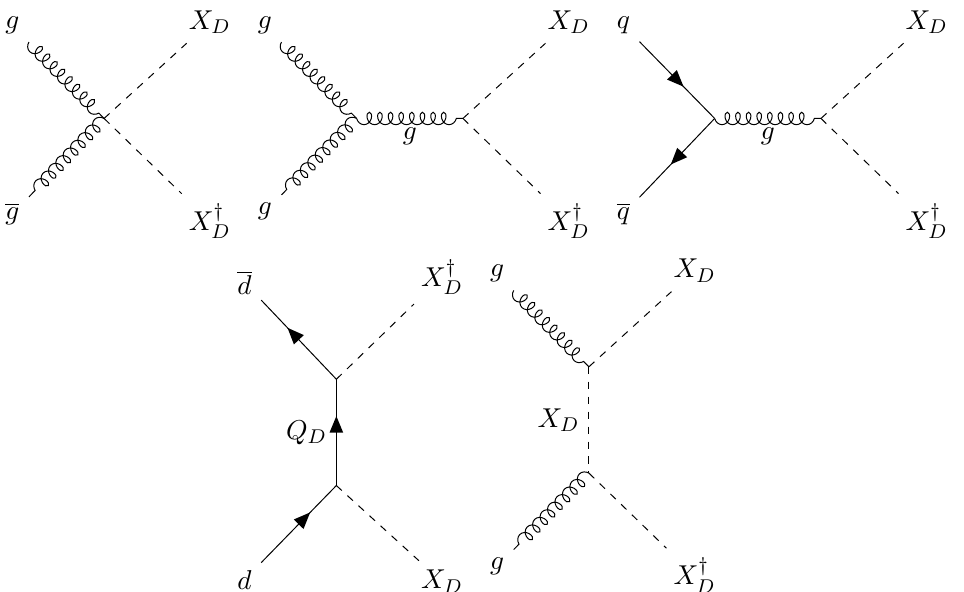
Figure 1. Feynman diagrams for the pair production of the mediator.